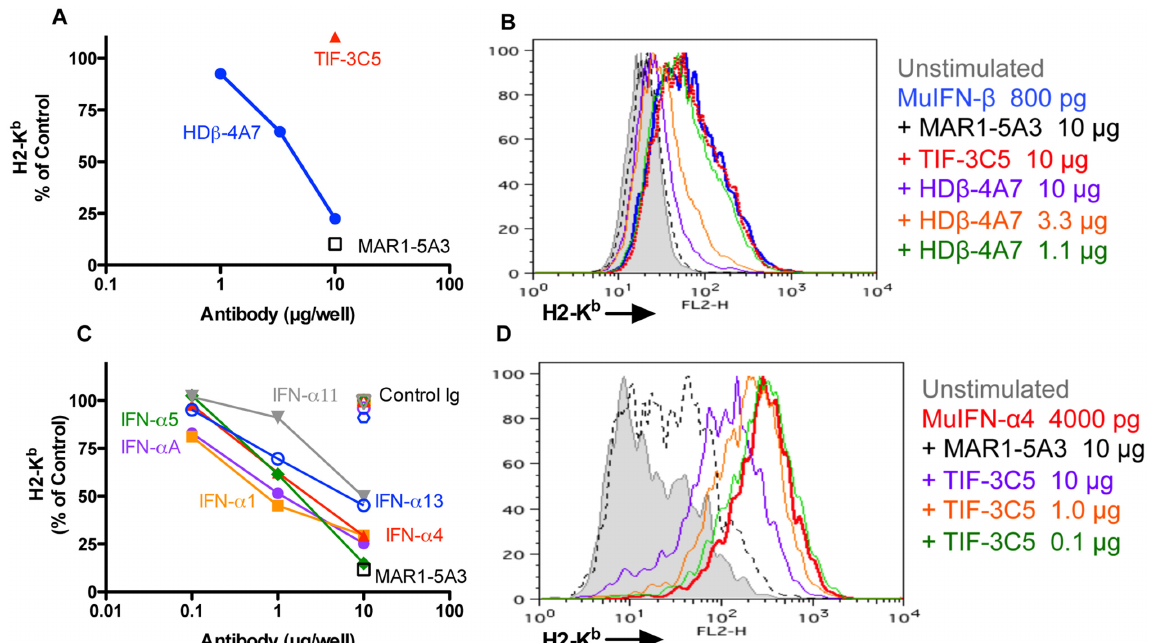
Fig 2. Inhibition of type I IFN MHC I upregulation. Type I IFNs (IFN- β , 800 pg; IFN- α 1, 40,000 pg; IFN- α 4, 4000 pg; IFN- α 5, 400 pg; IFN- α 11, 1000 pg; or IFN- α 13, 1000 pg) were preincubated with 1 to 10 μ g of HD β -4A7 ( A, B ) or 0.1 to 10 μ g of TIF-3C5 ( C, D ), MAR1-5A3 (10 μ g) or control hamster IgG (10 μ g) for 30 min then added to fibrosarcoma cells for 72 h and stained for H2-K b class I MHC antigens by flow cytometry. Plots and histograms are representative of three or more independent assays using either F510 ( A, B ) or 1969 ( C, D ) fibrosarcoma cells.